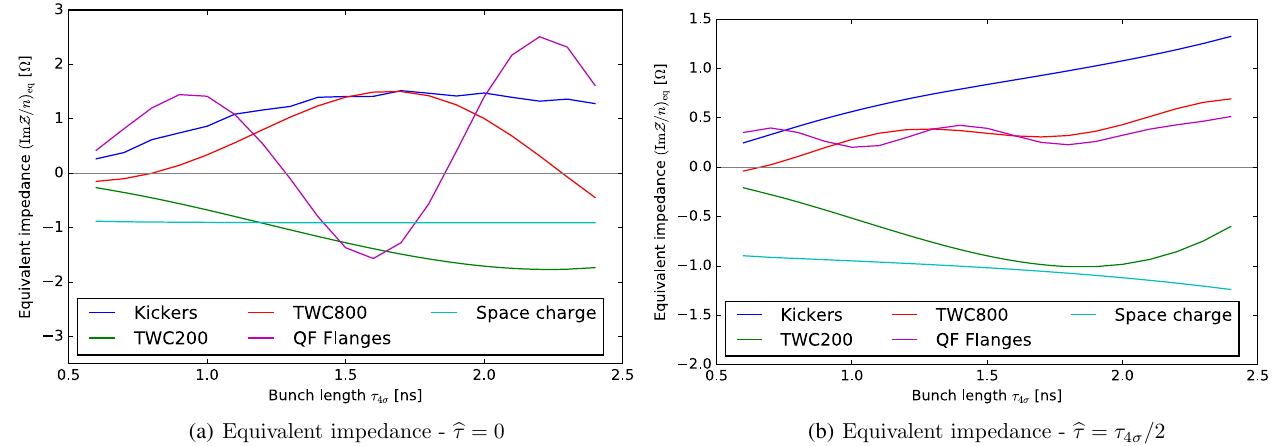
FIG. 9. The equivalent impedance ð Im Z =n Þ of the main SPS impedance sources (shown in Fig. 1), taken separately for a bunch eq distribution with μ ¼ 1 , and for small (left) and large (right) particle oscillation amplitudes ˆ τ